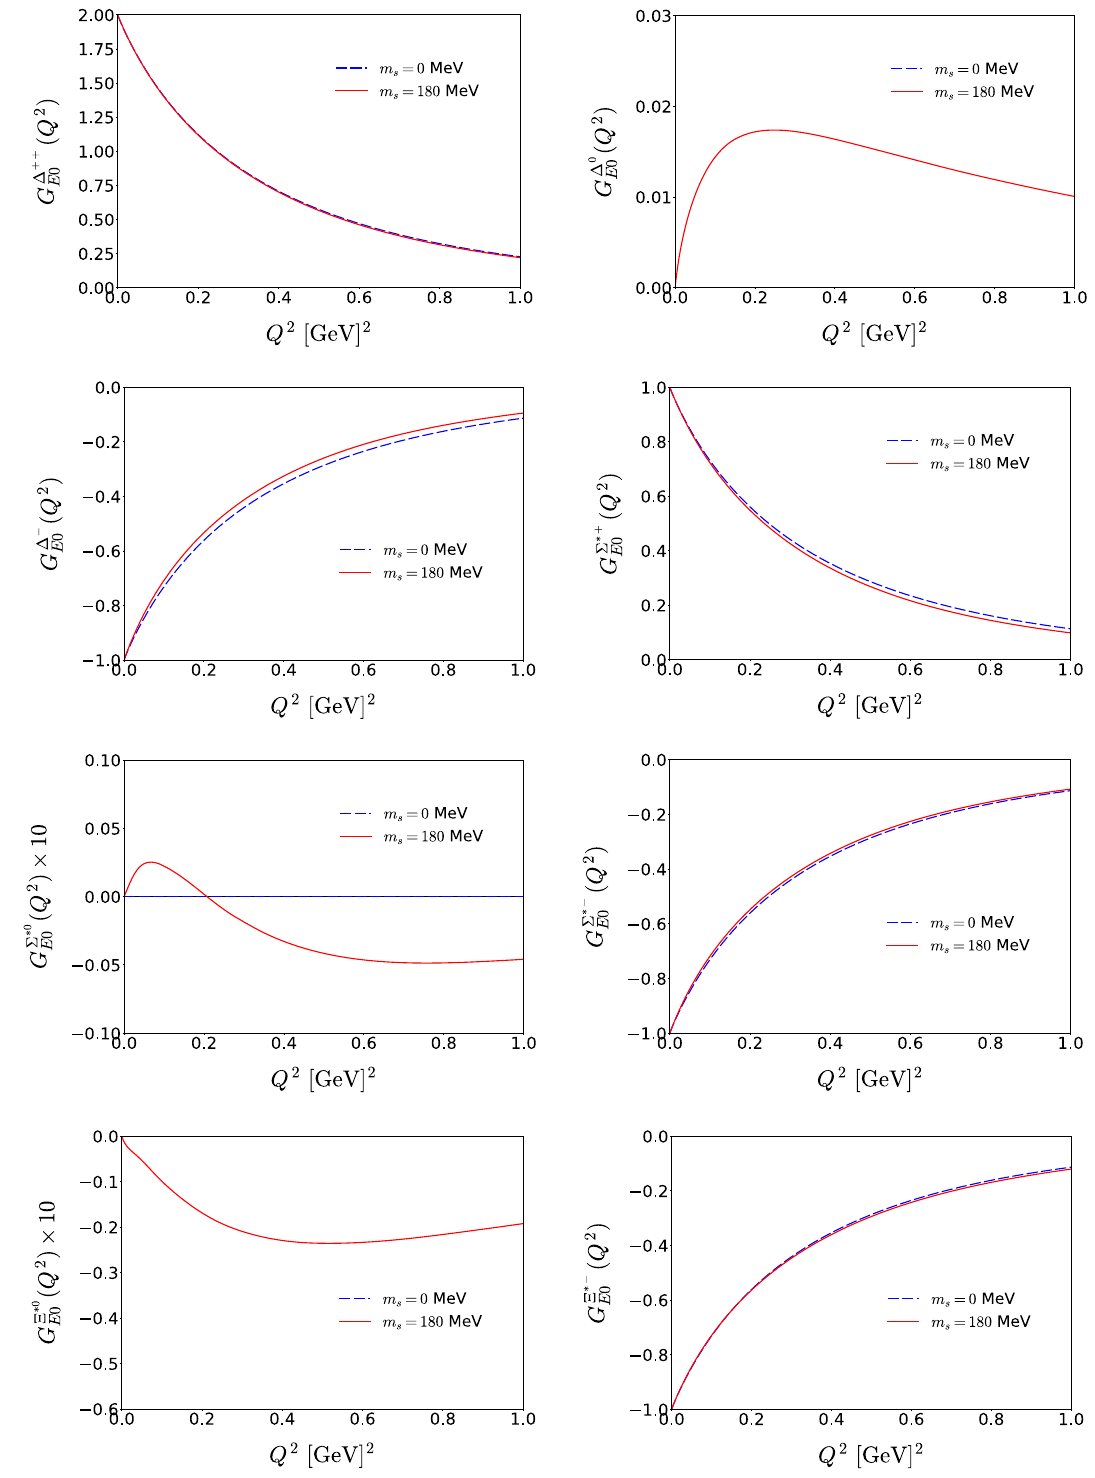
Fig. 8 Effects of the explicit flavor SU(3) symmetry breaking on the electric monopole form factors of the baryon decuplet except for the (cid:2) + and (cid:5) − baryons. Notations are the same as in Fig.